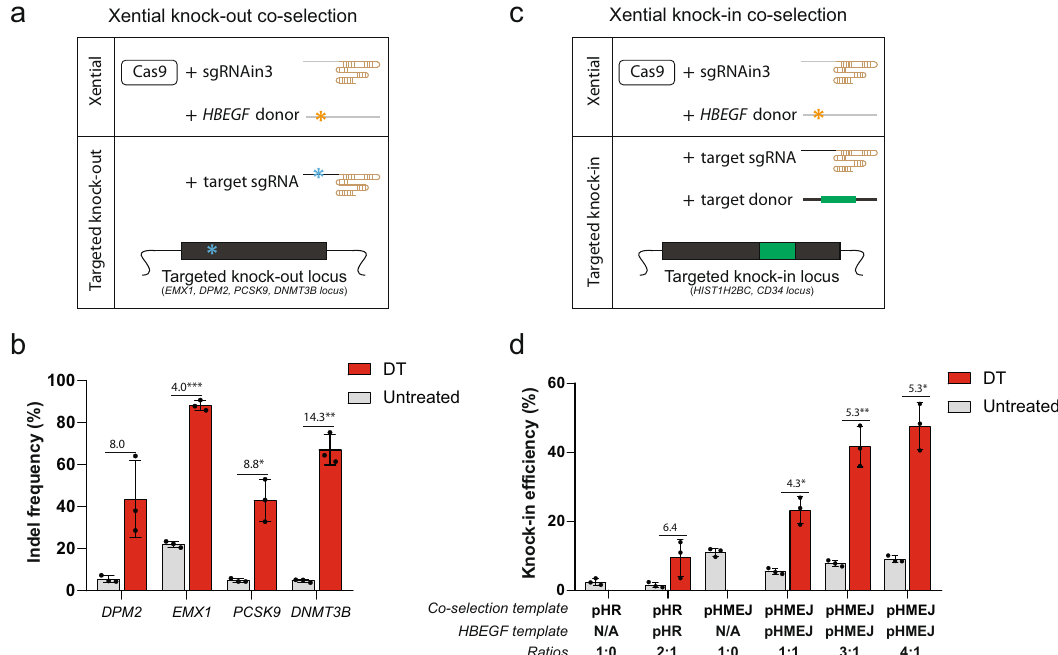
Fig. 4 Xential enables co-selection of knock-out and knock-in editing. a Strategy for co-selecting knock-out events with precise knock-in at the HBEGF locus. b Co-selection of SpCas9 indels in HEK293 cells. Cells were co-transfected with SpCas9, sgRNAin3, the pHMEJ repair template for HBEGF locus, and a sgRNA targeting a second genomic locus. Cells were cultivated with (DT) or without DT (Untreated) from 72 h after transfection until con fl uent. Genomic DNA were extracted from harvested cells and analyzed by NGS. c Strategy of co-selecting knock-in events with precise knock-in at the HBEGF locus. d Co-selection of knock-in events at a second locus, HIST1H2BC , in HEK293 cells. Cells were co-transfected with SpCas9, sgRNAs, and repair templates for both HBEGF and HIST1H2BC locus; cultivated with (DT) or without (Untreated) DT; analyzed by fl ow cytometry. Both pHR and pHMEJ templates were used. Ratios of the amount of sgRNA and template for HBEGF locus to that for HIST1H2BC locus are indicated below. N/A indicates no corresponding component was used. Values and error bars re fl ect mean ± s.d. of n = 3 independent biological replicates. Relative fold changes between untreated and DT-treated samples are indicated in the graphs. * P < 0.05, ** P < 0.01, *** P < 0.001, Student ’ s paired t test (two-tailed). P values are calculated as below: in b , DPM2 (0.0595), EMX1 (0.0003), PCSK9 (0.0228), and DNMT3B (0.0043); in d , P values from left to right are 0.1534, 0.0181, 0.0089, and 0.0128, respectively. Source data of Fig. 4b, d are provided as a Source data fi